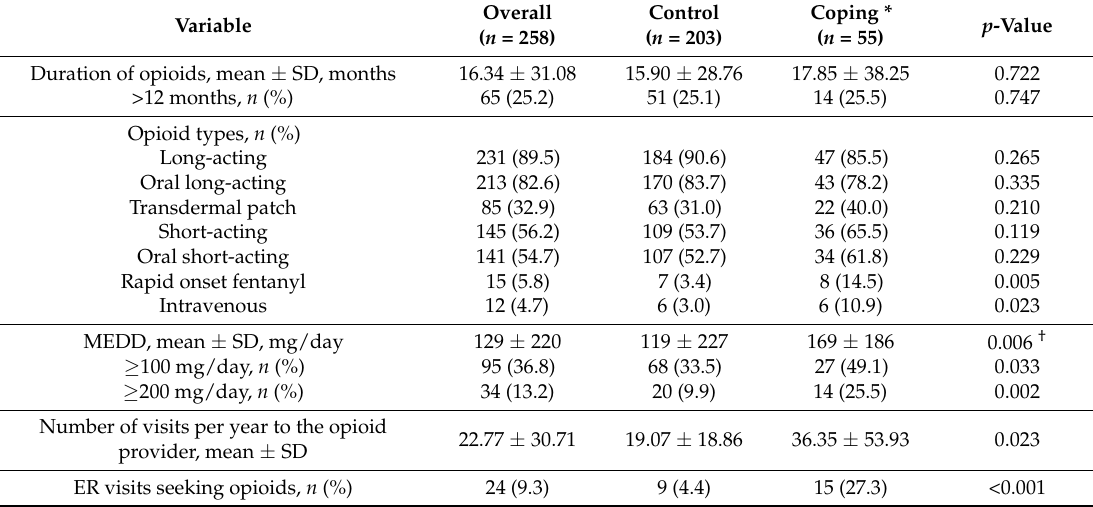
Table 3. Opioid-related